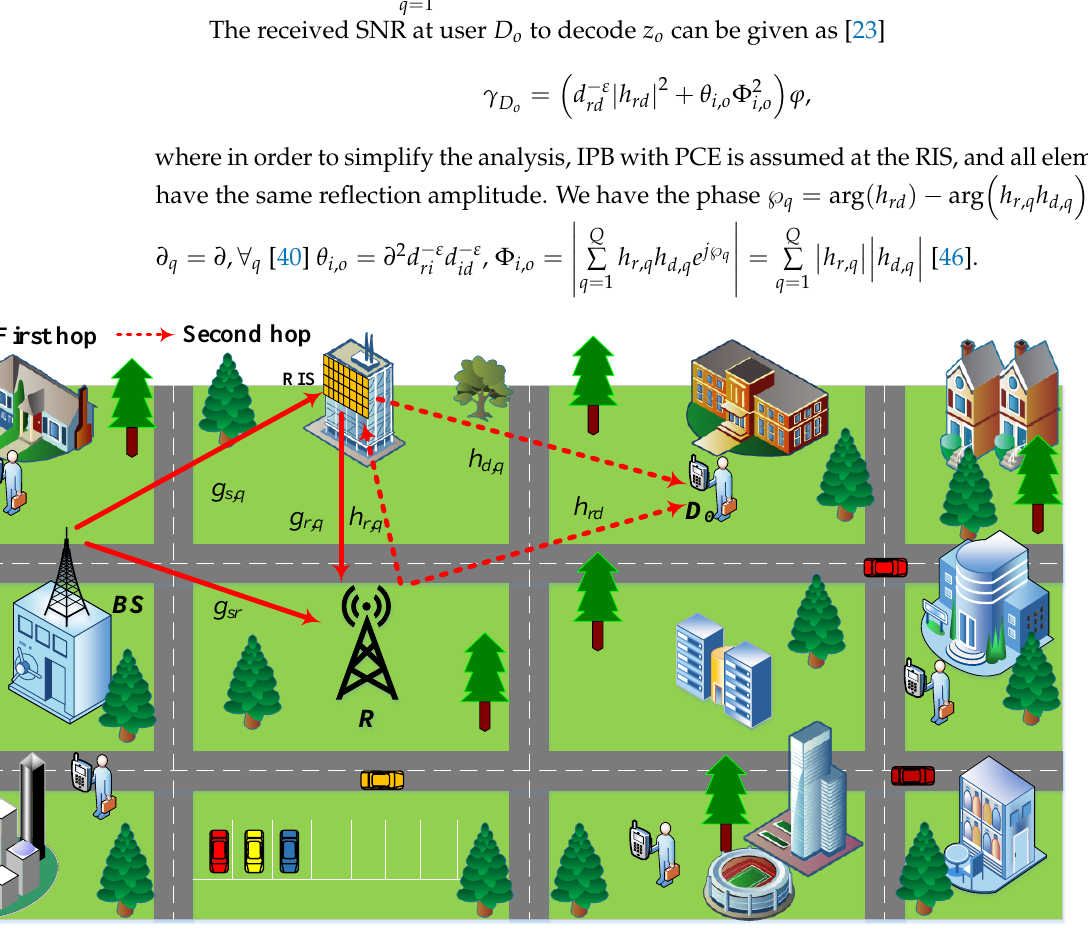
Figure 2. Hybrid relay RIS-OMA